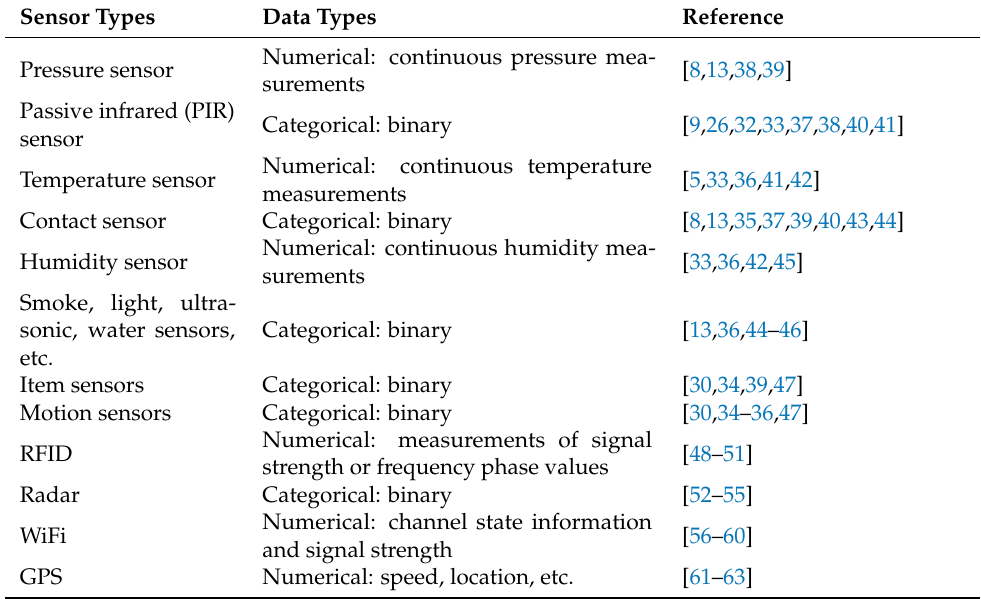
Table 3. Commonly- used sensors in ambient sensor-based abnormal behaviour